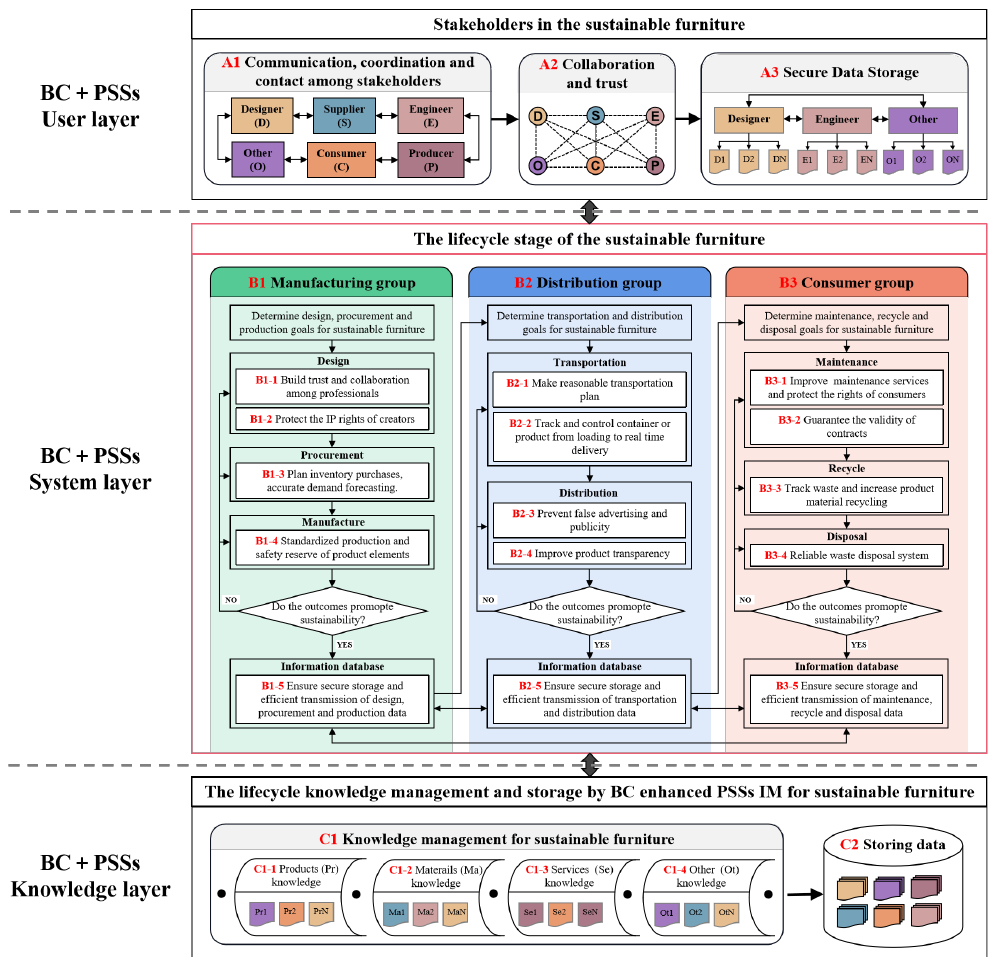
Figure 10. High-level BC-PSSs framework for sustainable furniture (generated by authors).